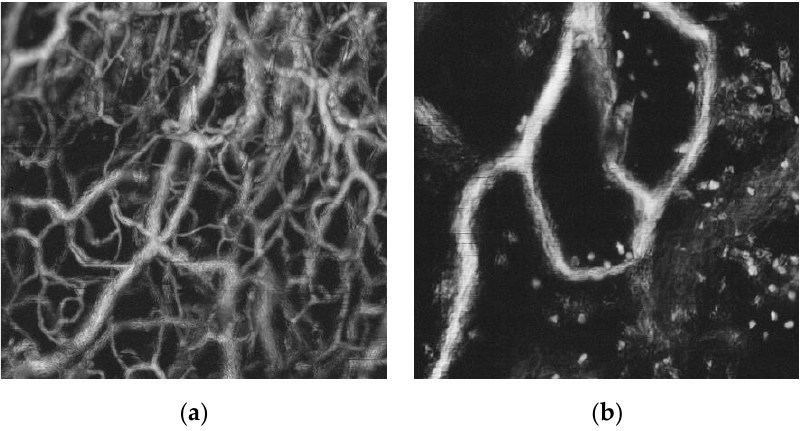
Figure 10. Photoacoustic image of a mouse ear: ( a ) maximum amplitude image of 1 mm × 1 mm; ( b ) image of a small fragment of image a (taken with the permission of [44]).